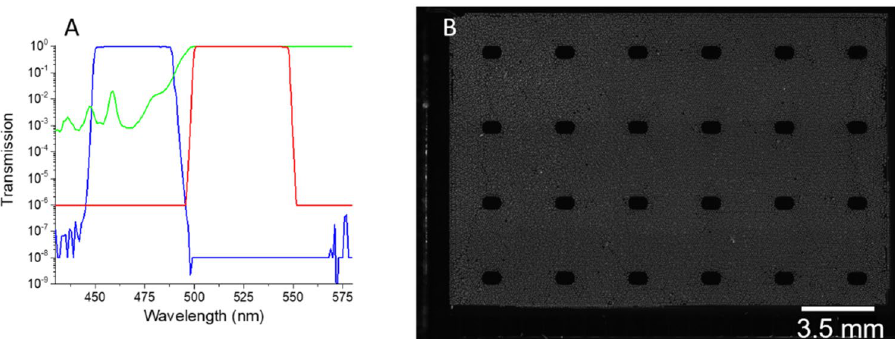
Figure 1. ( A ) Fluorescein isothiocyanate (FITC) filter set transmission showing properties of the excitation filter (blue), dichroic mirror (red), and emission filter (green). Both excitation and emission filters have a light incident angle of 0° while the dichroic mirror is 45°. ( B ) A fluorescent image of a digital polymerase chain reaction (dPCR) chip from Stilla 24 using an FITC filter set. The droplets contained precipitated salts from the buffer exhibiting false fluorescent